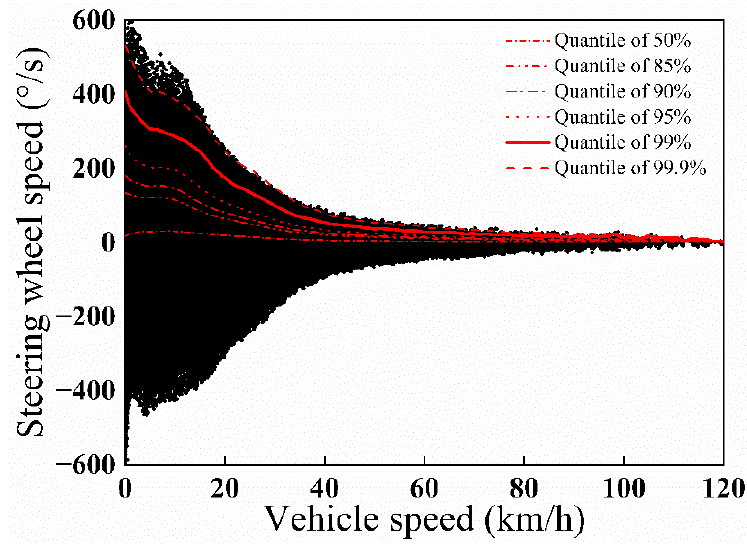
Figure 14. The comparison of distribution and quantile for steering wheel speed at different speeds.